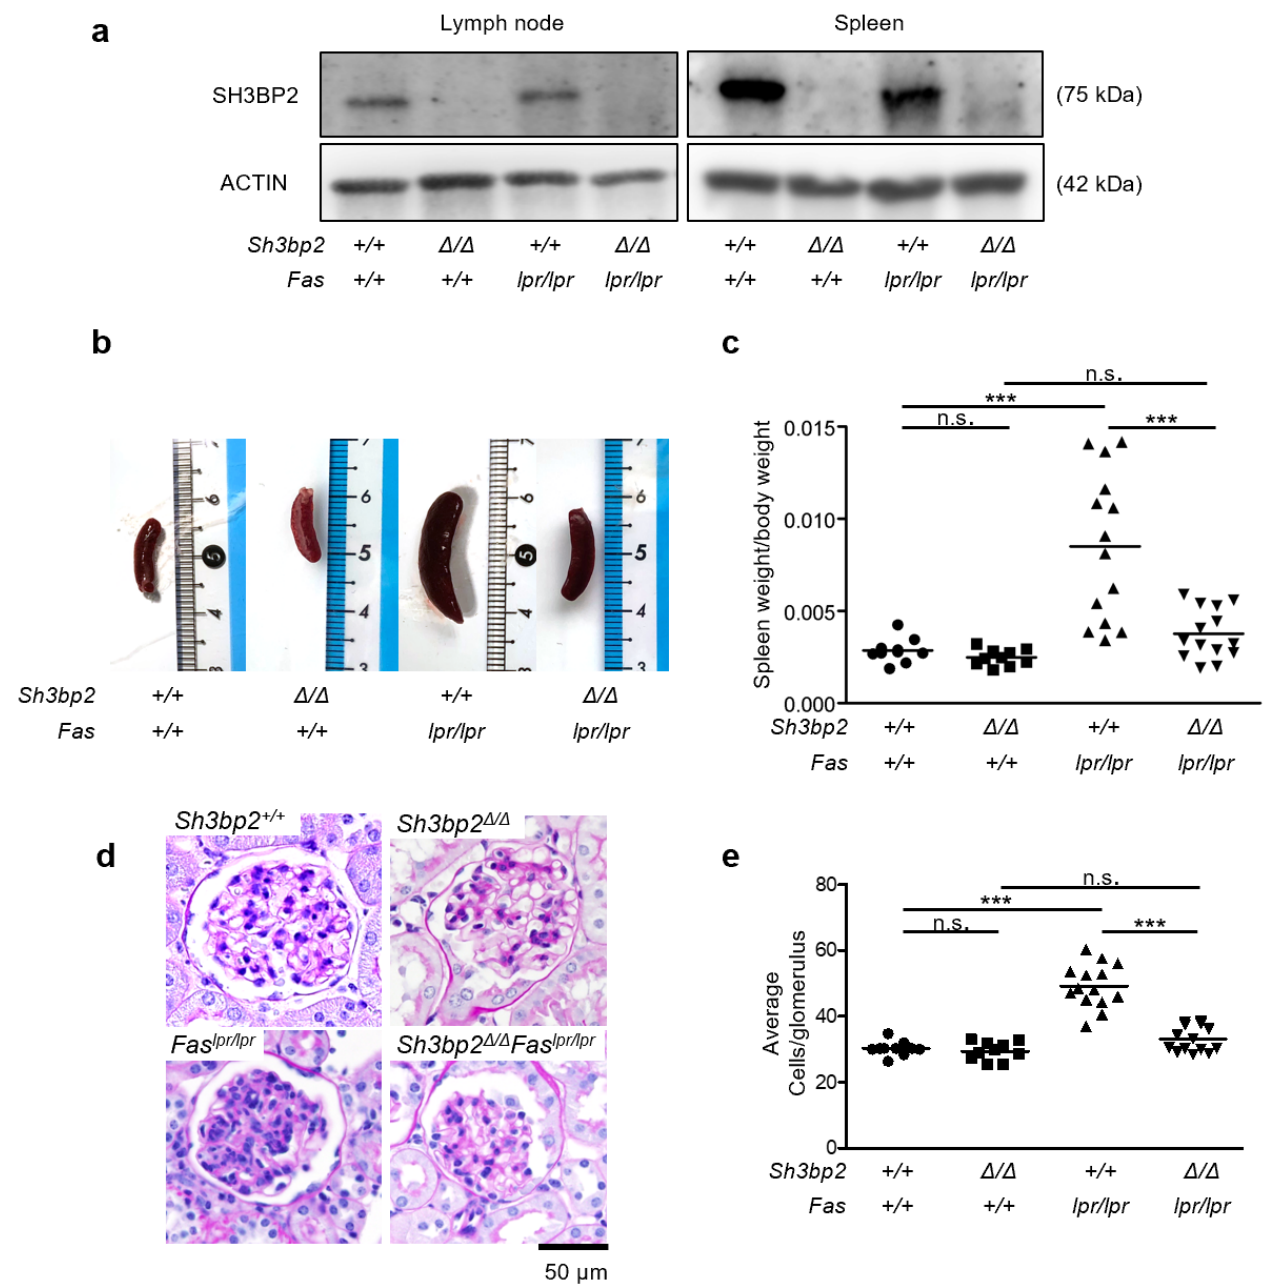
Figure 1. SH3BP2 deficiency improves splenomegaly and the proliferative changes in glomeruli of the Fas lpr/lpr lupus-prone mice. ( a ) Immunoblot analysis for SH3BP2. Protein samples were collected from lymph nodes and spleens of the indicated mice. SH3BP2 protein levels were determined by western blotting. Actin was used as the loading control. ( b – e ), Sh3bp2 +/+ ( n = 10), Sh3bp2 Δ / Δ ( n = 10), Fas lpr/lpr ( n = 14), and Sh3bp2 Δ / Δ Fas lpr/lpr mice ( n = 14) were analyzed at the age of 35 weeks. ( b ) Representative images of the spleen. ( c ) Spleen weights per body weights were determined. ( d ) Representative images of periodic acid-schiff (PAS)-stained kidney sections. Original magnification, 400×. Bar, 50 μ m. ( e ) Quantification of the number of cells in the glomeruli. At least 10 glomeruli per mouse were assessed. The numbers of nuclei in the glomerular cross-sections were counted, and the averages of the nuclei per glomerulus were determined. Each dot denotes an individual mouse, and horizontal lines represent the means. *** p < 0.001; n.s.= not significant.